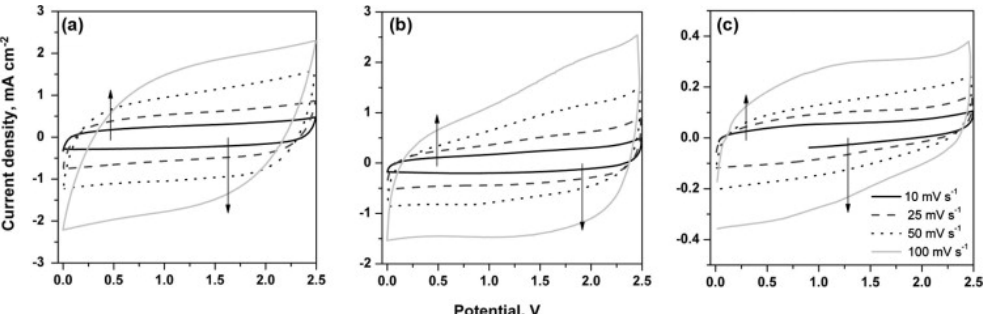
Figure 13. CV curves at various scan rates for the electrodes based on: ( a ) commercial GNP, ( b ) MnO 2 - GNP and ( c ) GNP exfoliated from graphite. The slight redox peak visible in ( b ) shows the very limited pseudocapacitance that was achieved with the MnO 2 -functionalised GNPs. Reprinted with permission from Ref. [51]. 2015,